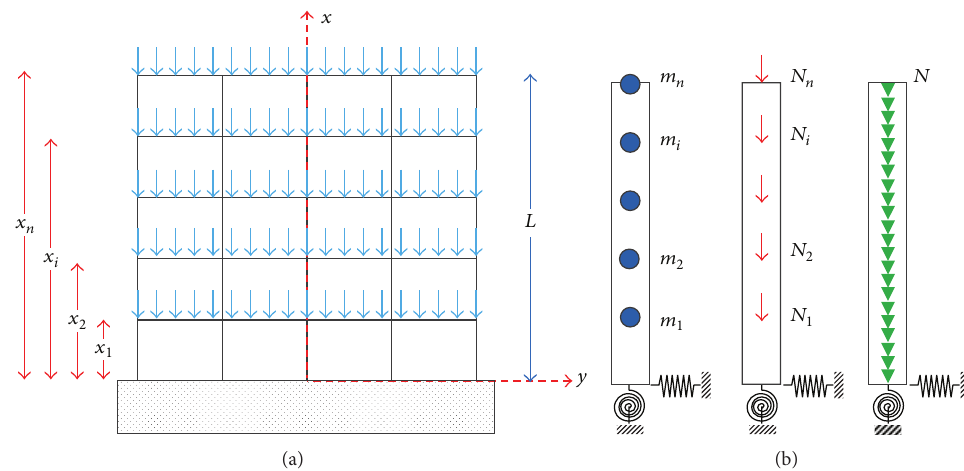
Figure 7: Analytical model: (a) schematic drawing of a doubly symmetric structure, (b) equivalent beam model of the